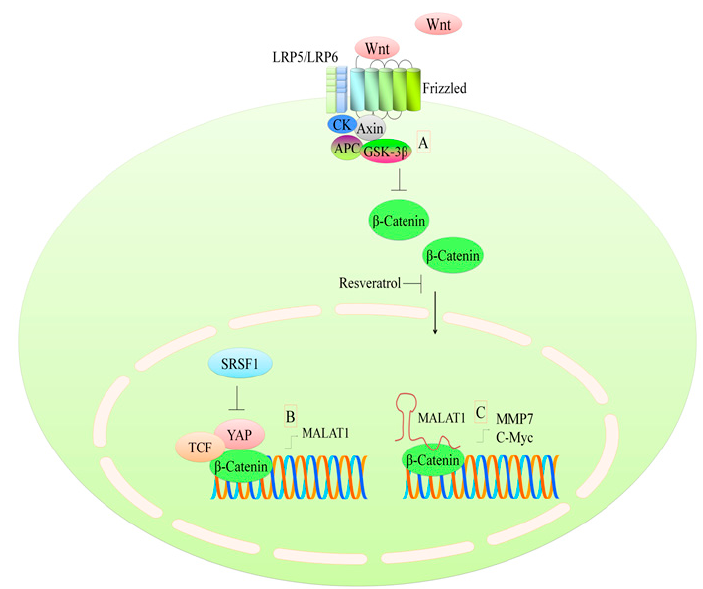
Figure 2. ( A ) WNT/ β -catenin signaling axis. Resveratrol effectively inhibits the nuclear accumulation of β -catenin. β -catenin works synchronously with various proteins to modulate the transcription of different genes; ( B ) SRSF1 inhibits YAP and represses the β -catenin-mediated upregulation of MALAT1; ( C ) β -catenin works with MALAT1 and increases the expression of MMP7 and C-Myc. APC: adenomatous polyposis coli; CK: casein kinase; GSK-3 β : glycogen synthase kinase 3 beta; LRP: low-density lipoprotein-receptor-related protein; MALAT1: metastasis-associated lung adenocarcinoma transcript 1; MMP&: matrix metalloproteinase-7; SRSF1: serine and arginine rich splicing factor 1; TCF: T-cell factor; YAP: YES-associated protein; 65-KD.